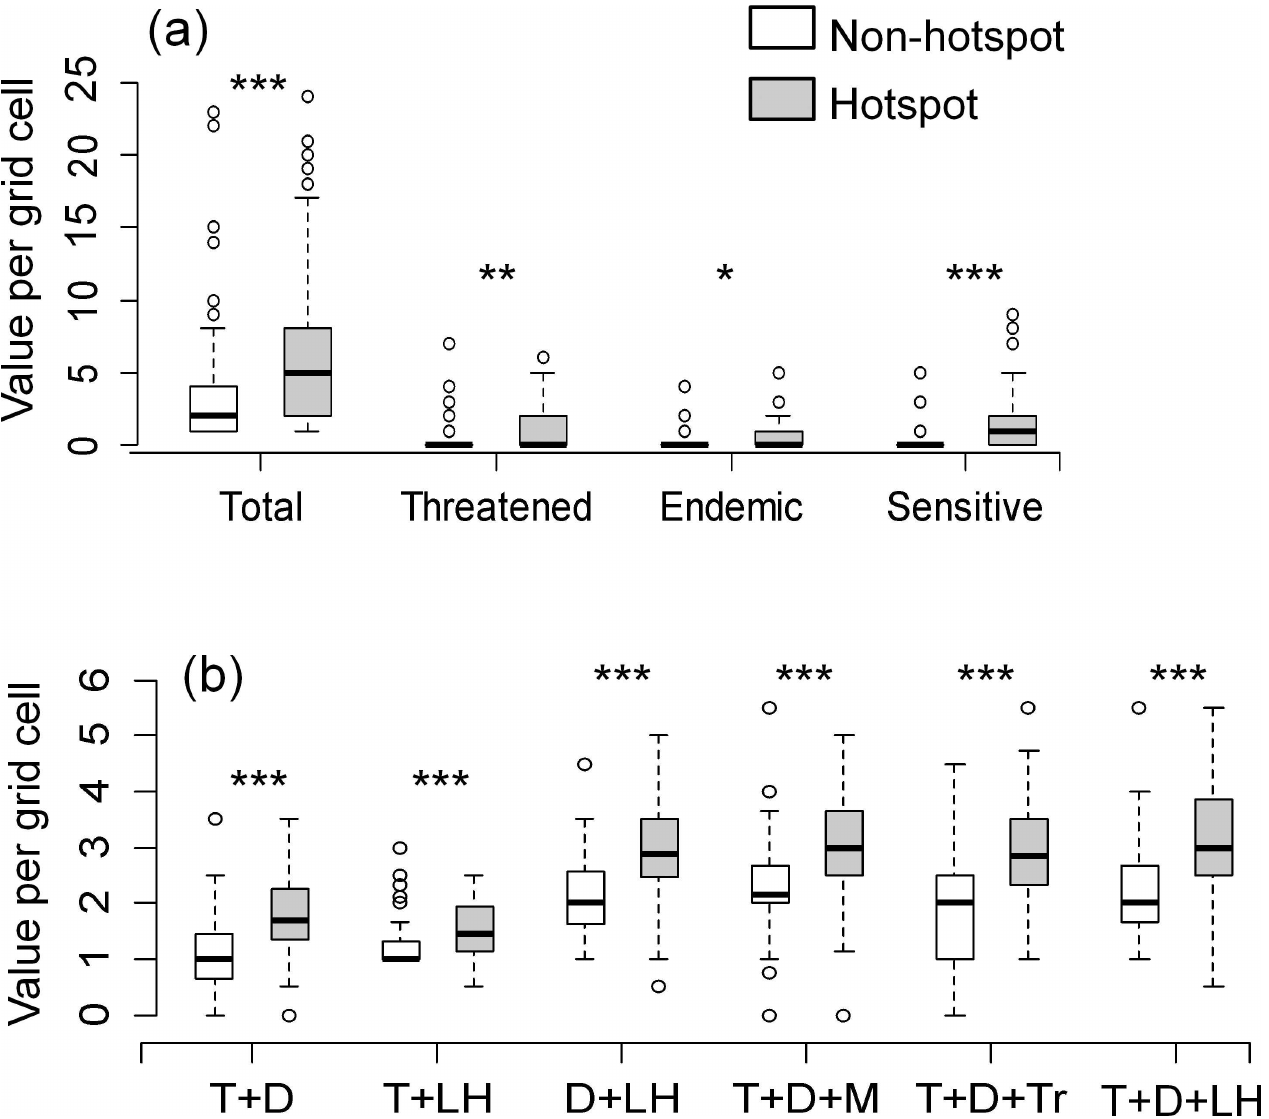
Fig 3. Diversitymeasurecomparison amonghotspots vs. non-hotspots. Box and whisperplots comparingmediancount-based (a) and score-based (b) diversity measurein biodiversity hotspotvs. non-hotspotgridcells. Diversity measurescores were calculatedas described in Table 1. Mann-Whitney non-parametrictests were used to assess differences in values. T = threatstatus;D = distribution; M = mobility; Tr = trophiclevel; LH = life history. Dots indicateoutlyingvalues. * p < 0.05; ** p < 0.01; *** p < 0.001